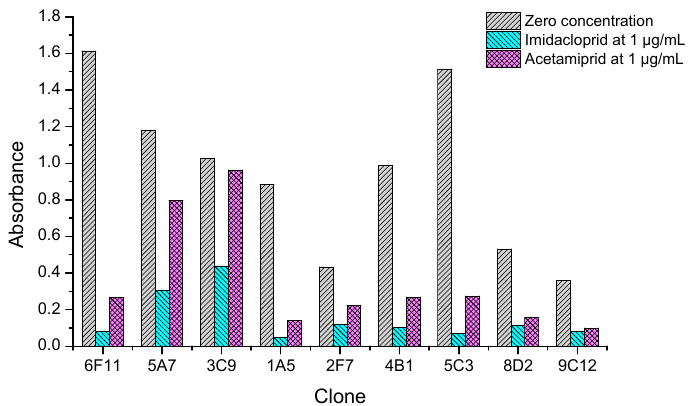
Figure 3. Inhibition tests of the positive clones by dual-target icELISAs coated with imidacloprid-OVA at 10 µg/mL. Data are the mean values of two replicates.